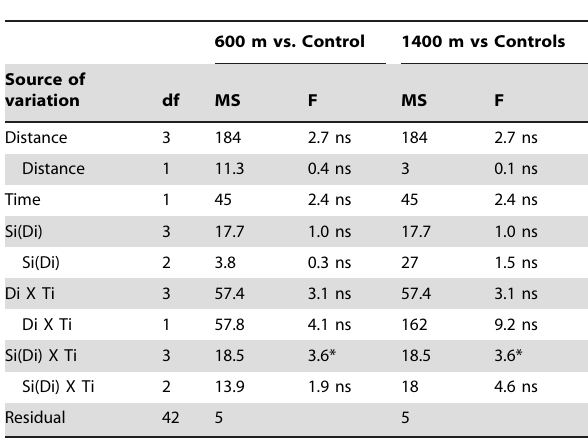
Table 2. Univariate analyses of variance of the number of taxa on panels submerged in different sites in all sampling times.